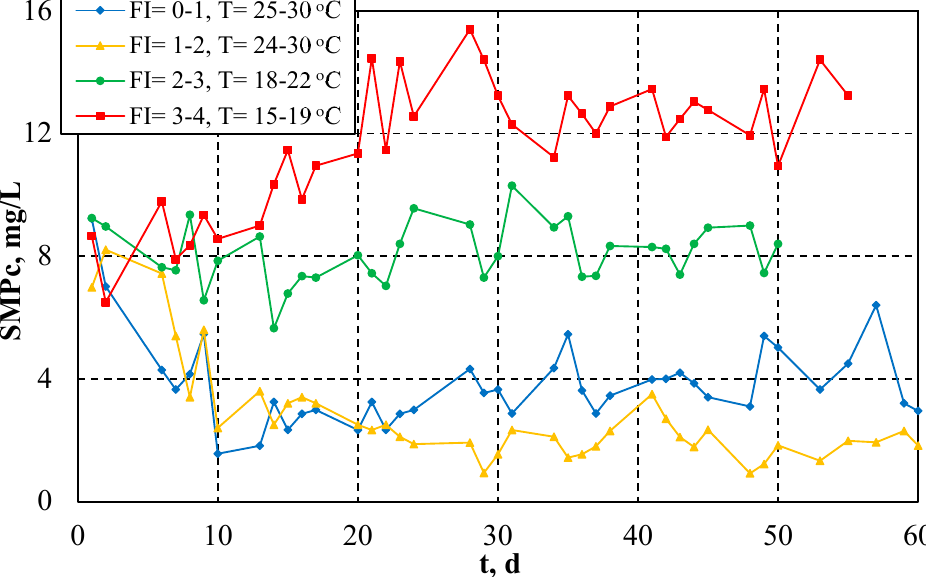
Figure 5. Effect of FI and temperature on SMP c concentration.